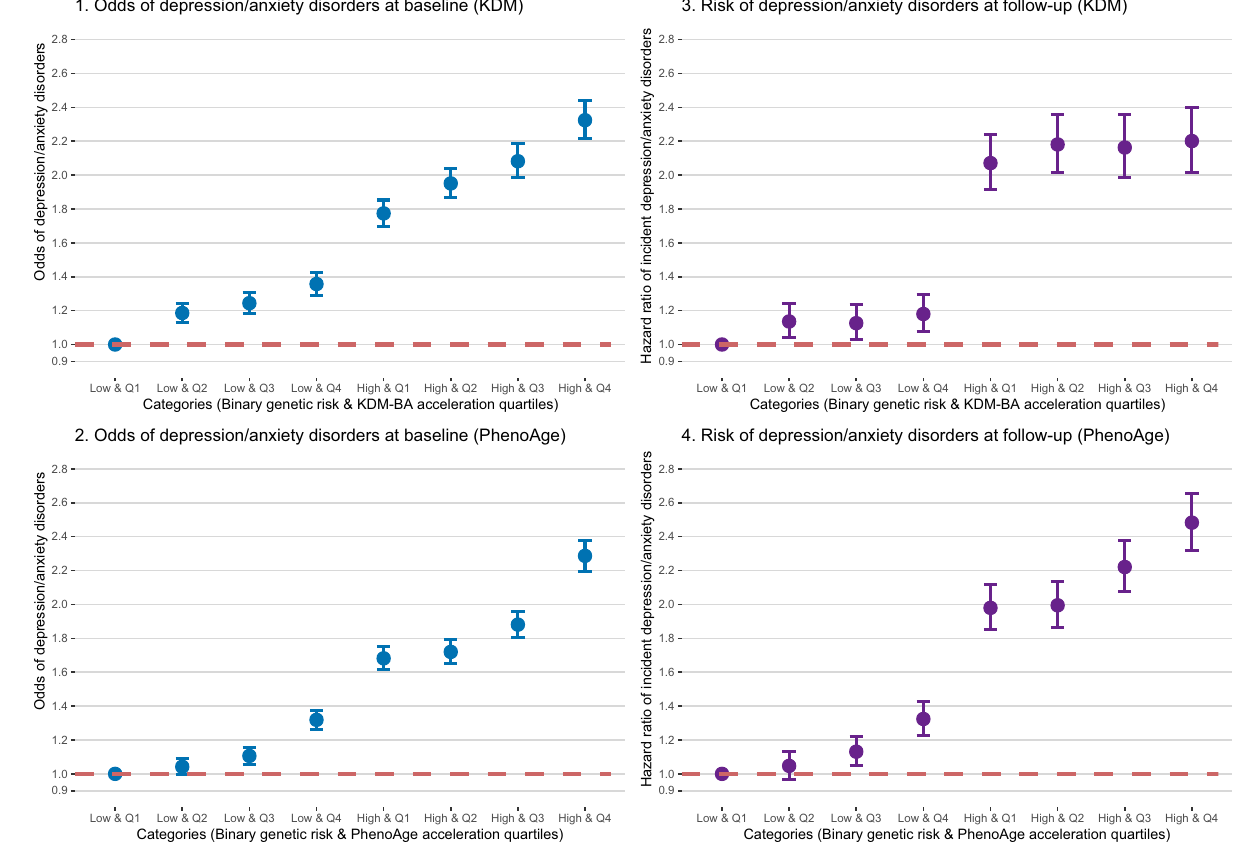
Fig. 4 | Joint associations of genetic risk and biological age accelerations with the odds ofdepression/anxietydisorders at baseline and incident depression/ anxiety disorders at follow-up. Dots (centers of error bars): Point estimate; Error bar:95%con fi dencelimits;Dashline:Referenceline;Logisticregressionmodelwas used inanalyses forthe odds of depression/anxiety atbaseline and Coxregression model was used for the risk of incident depression/anxiety during the follow-up.